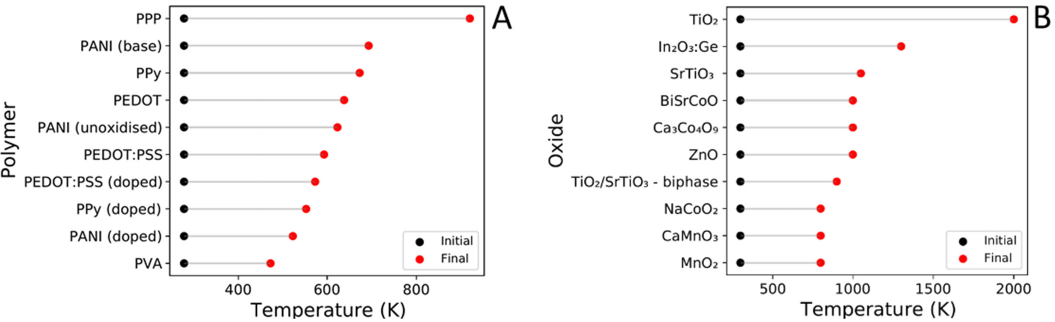
Figure 7. Reported temperature ranges of organic polymers ( A ) and oxides ( B ) in air as a function of temperature (K). (A) PPP [202], PANI (Base) [206], PPy [207], PEDOT [208], PANI (unoxidised) [209], PEDOT:PSS [208], PEDOT:PSS (doped) [208,210], PPy (doped) [207], PANI (doped) [206], and PVA [211]. (B) TiO 2 [212], In 2 O 3 :Ge [80], SrTiO 3 [213], BiSrCoO [80], Ca 3 Co 4 O 9 [214], ZnO [23],